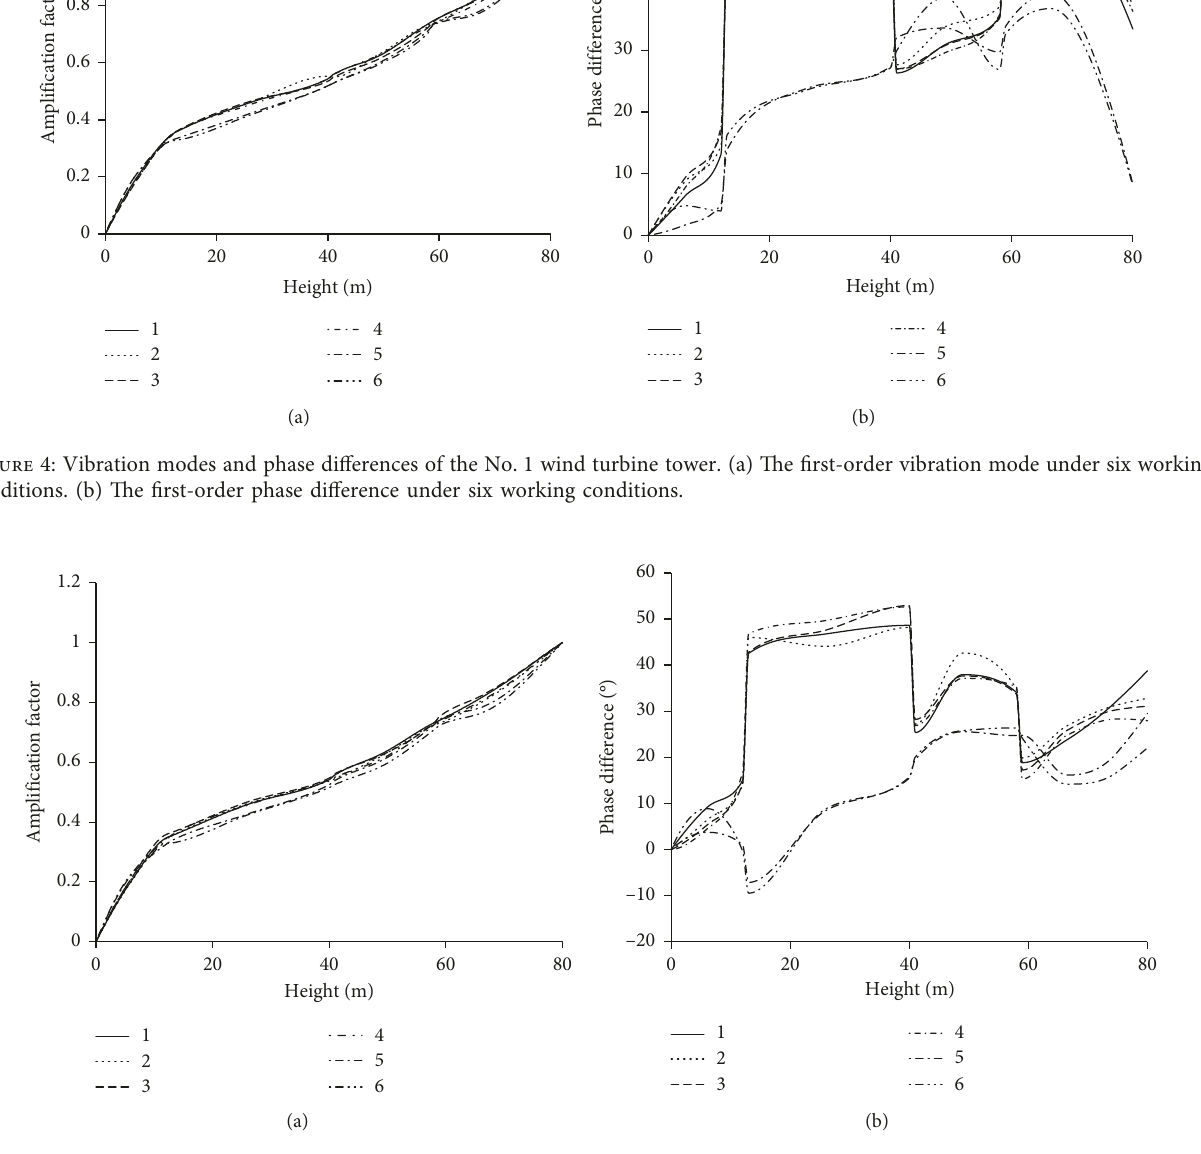
Figure 5: Vibration modes and phase differences of the No. 2 wind turbine tower. (a) The first-order vibration mode under six working conditions. (b) The first-order phase difference under six working